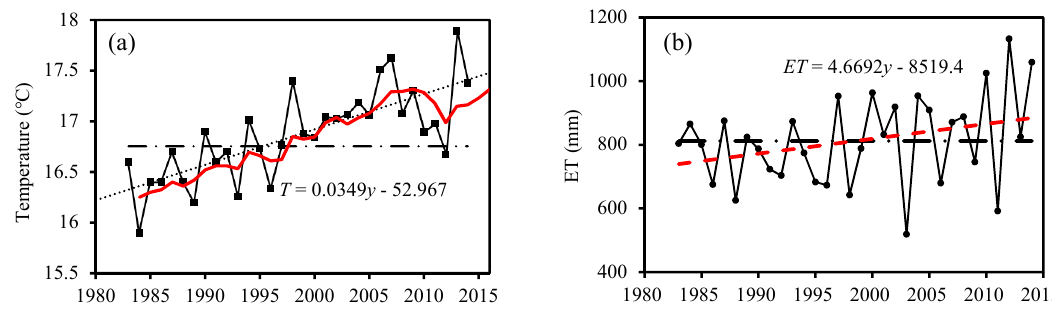
Figure 6. Variation trend of annual mean temperature ( a ) and ET ( b ) from 1983 to 2014.